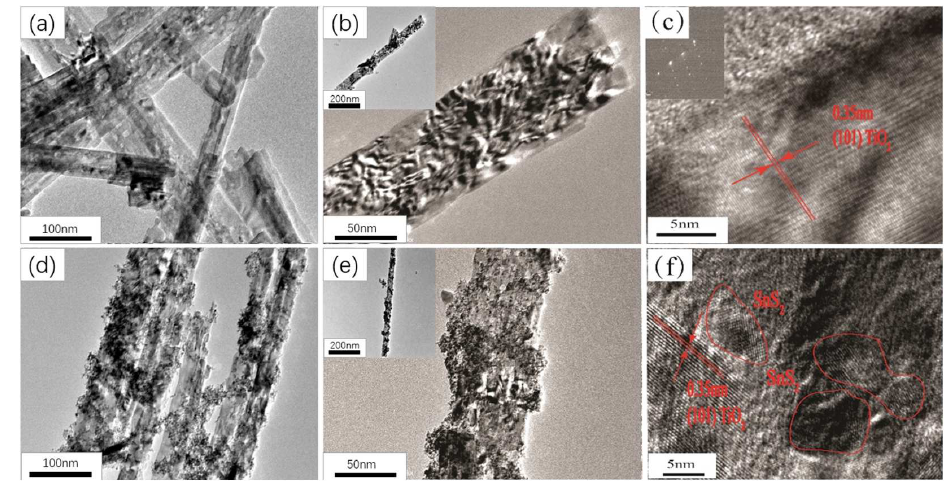
Figure 4. TEM images ( a , b ) and HRTEM image ( c ) of the TiO 2 nanobelts. TEM images ( d , e ) and HRTEM image ( f ) of TiO 2 -SnS 2 . Insets: (b) TEM image of single-TiO 2 nanobelt, ( c ) the electron diffraction pattern image of TiO 2 and ( e ) TEM image of single-SnS 2 -TiO 2 nanoheterostructure.